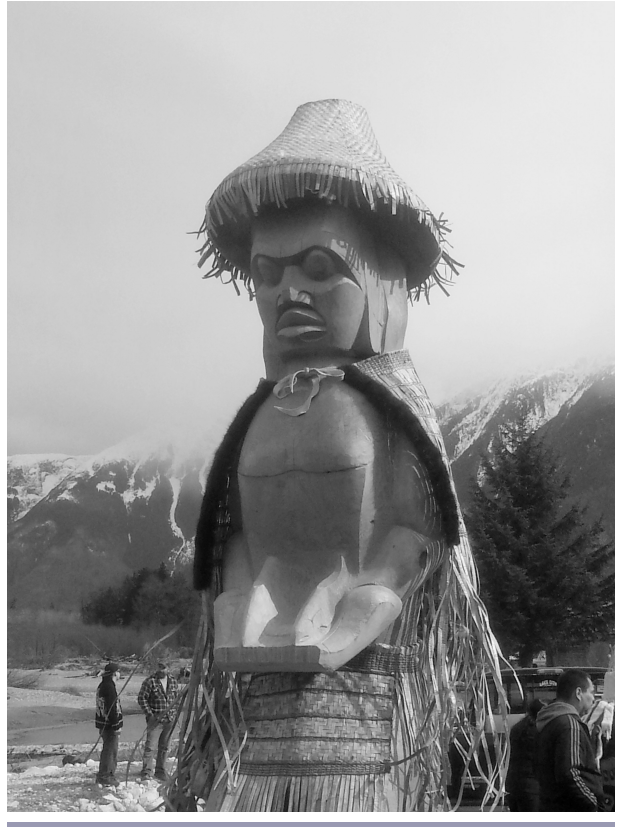
Fig. 4 . Nuxalk sputc (eulachon, Thaleichthys pacificus ) pole erected during the first annual eulachon ceremony. Re-dressed in cedar regalia every year, the pole depicts Raven in human form bringing the first eulachon to the Bella Coola